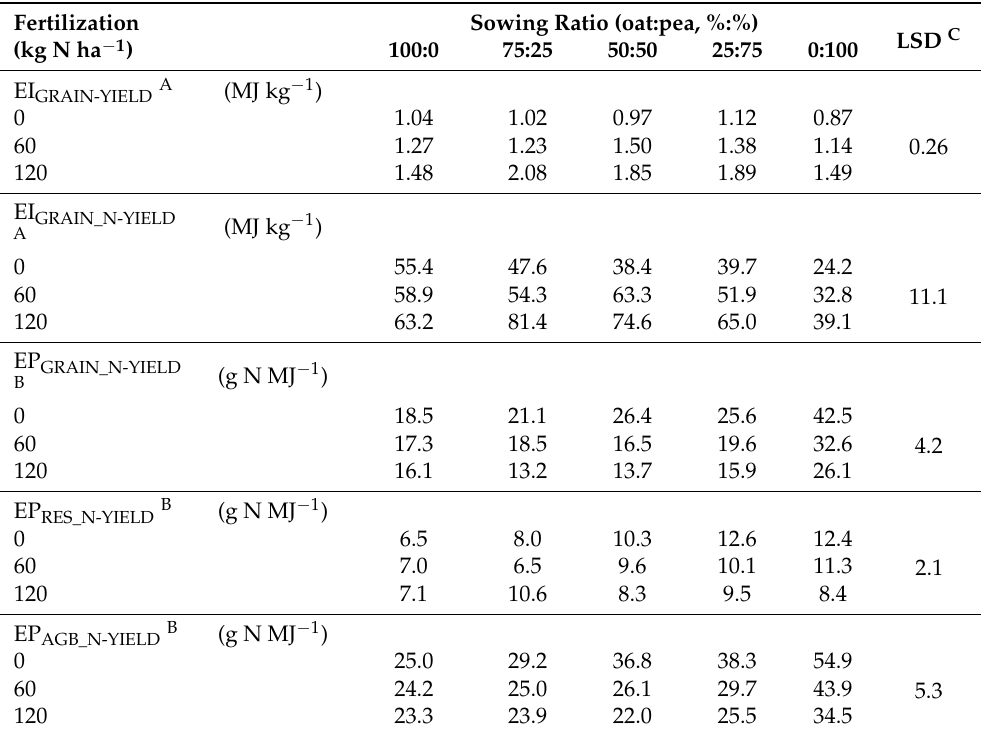
Table 9. Energy efficiency parameters of oat and pea pure crop stands and oat:pea intercrops as affected by sowing ratio and N fertilizer.